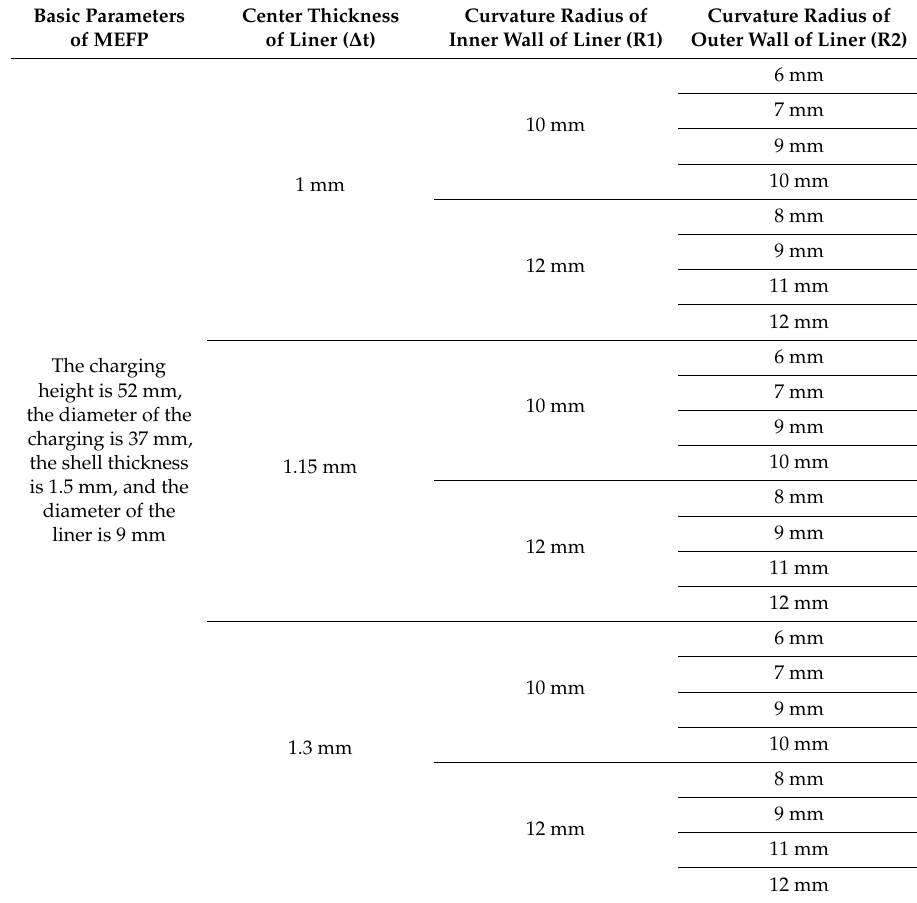
Table 6. Structural design of MEFP.